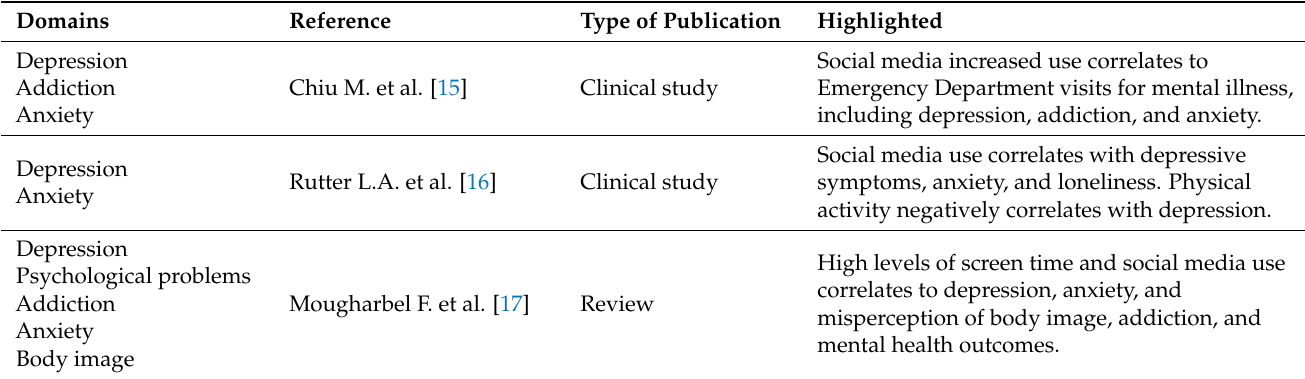
Table 2. Social media and